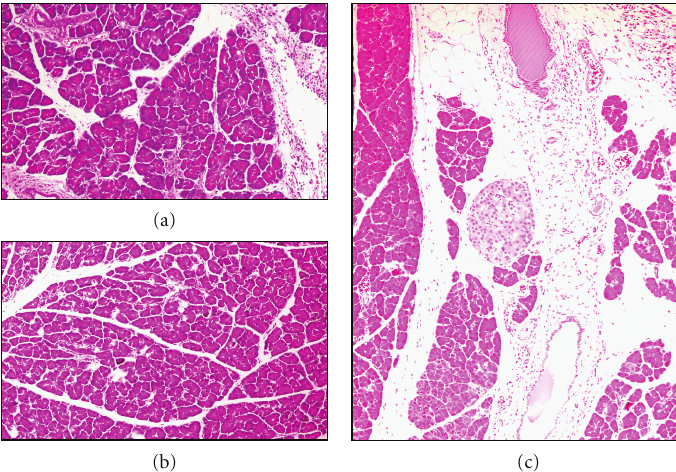
Figure 4: Representative photomicrographs of the pancreas after intraductal infusion of 40 μ L/100 g body weight of 0.1% NaTc solution (a), after intraductal infusion of 40 μ L of 0.01% agarose (b), or after intraductal infusion of a mixture solution of 0.1% NaTc and 0.01% agarose at amount of 40 μ L/100 g body weight (c). (a) On day 14 after intraductal infusion of 40 μ L/100g body weight of 0.1% NaTc solution, the pancreas was histologically normal. (b) On day 14 after intraductal infusion of 40 μ L/100 g body weight of 0.01% agarose, the pancreas appeared almost normal. (c) On day 14 after intraductal infusion of a mixture of 0.01% agarose and 0.1% NaTc solution at an amount of 40 μ L/100 g body weight, acinar architecture was partially destroyed and replaced by fatty tissues. Dilated pancreatic duct with focal acinar cell necrosis and inflammatory cell infiltration were seen. (Hematoxylin and eosin staining, original magnification × 25).